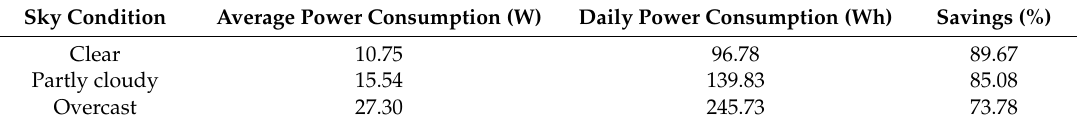
Table 7. Lighting power consumption and lighting energy-savings ratio according to the sky conditions.